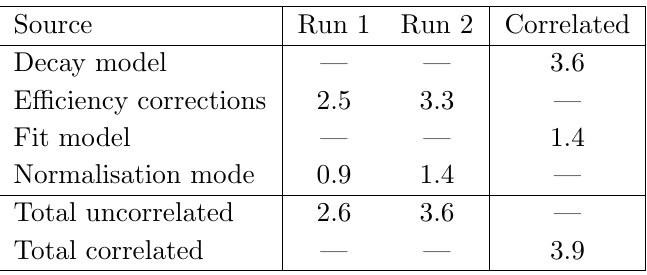
Table 3. Systematic uncertainties in percent associated to the ratio of branching fractions, r B , for the di(cid:11)erent data taking periods. For uncertainties that are correlated between data taking periods, a single value is